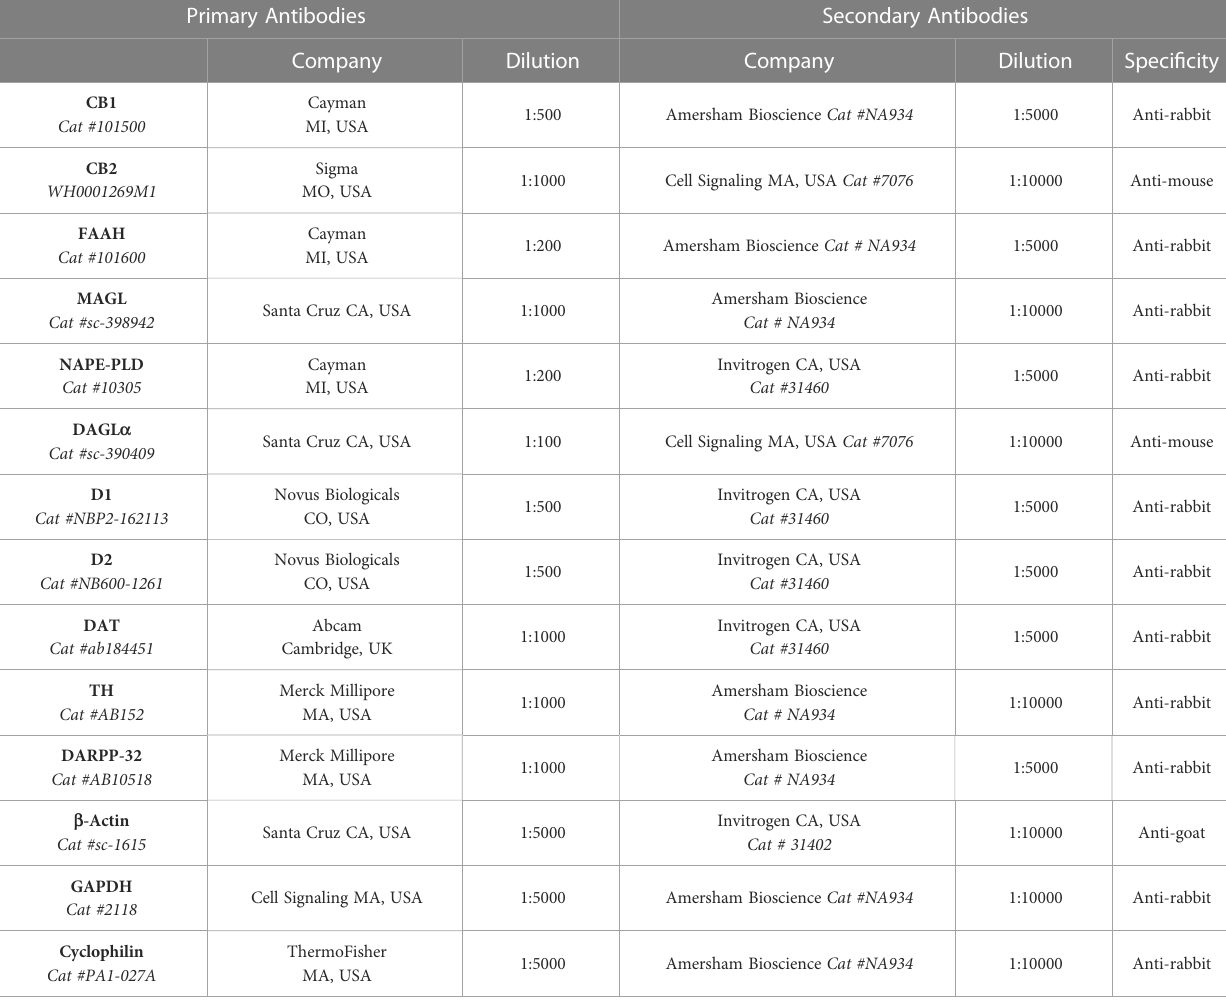
TABLE 2 Primary and secondary antibodies used for Western